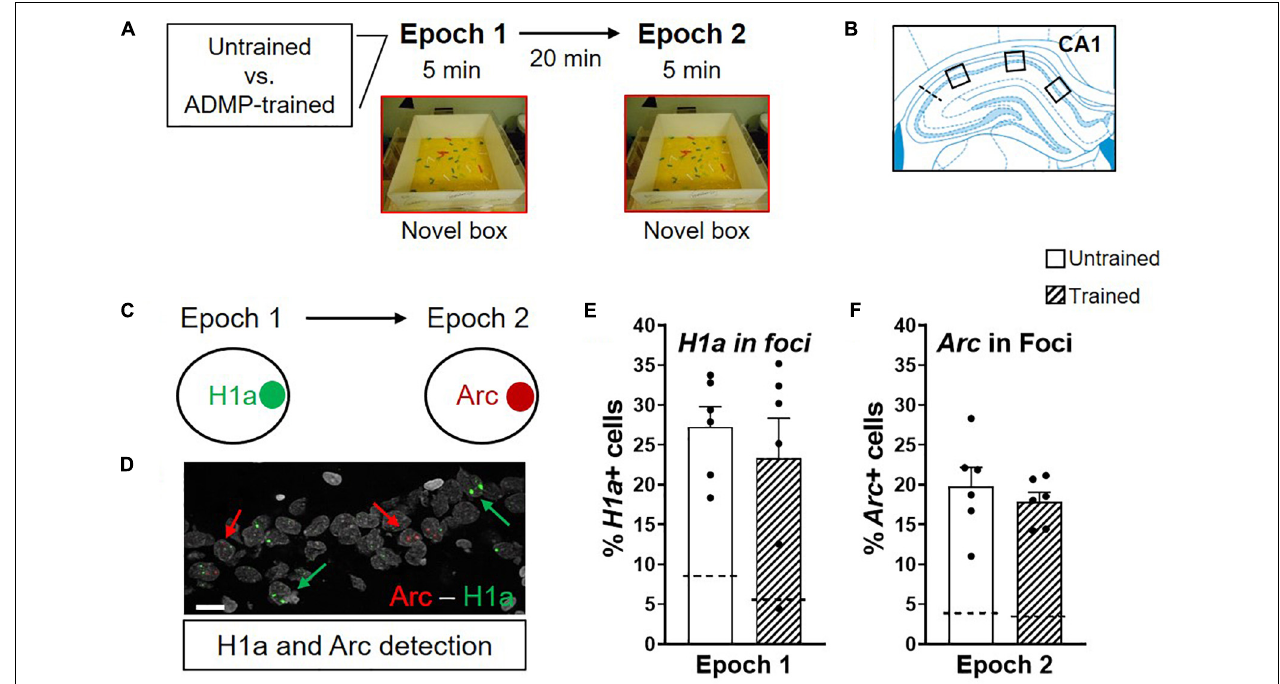
FIGURE 1 | ADMP training does not change the proportion of Arc + and H1a + neurons after novel box exploration. (A) Experimental design. ADMP-trained or untrained young rats explored a novel box during epoch 1 and/or epoch 2, separated by 20 min. (B) Images were collected in 3 areas of the CA1. (C) H1a and Arc expression in nuclei was used to quantify neuronal activation after novel box exploration during epoch 1 or epoch 2, respectively. (D) An example of CA1 cells showing H1a + (the green arrow) or Arc + (the red arrow). A scale bar: 10 µ m. (E) ADMP training did not change the percentage of H1a + neurons activated by novelty exploration during epoch. (F) ADMP training did not change the percentage of Arc + neurons activated by novelty exploration during epoch 2. All data are presented as mean ± SEM. The dashed line represents the basal level of activation without novel box